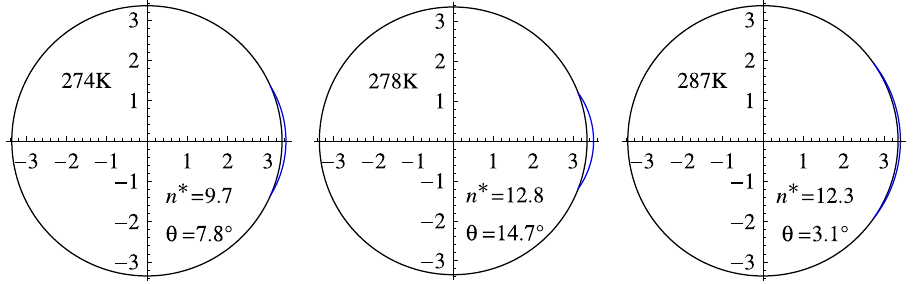
Figure 4. To-scale cross-sections of the critical seed-cap assembly consistent with the geometric factors listed in Table 3 (scale in